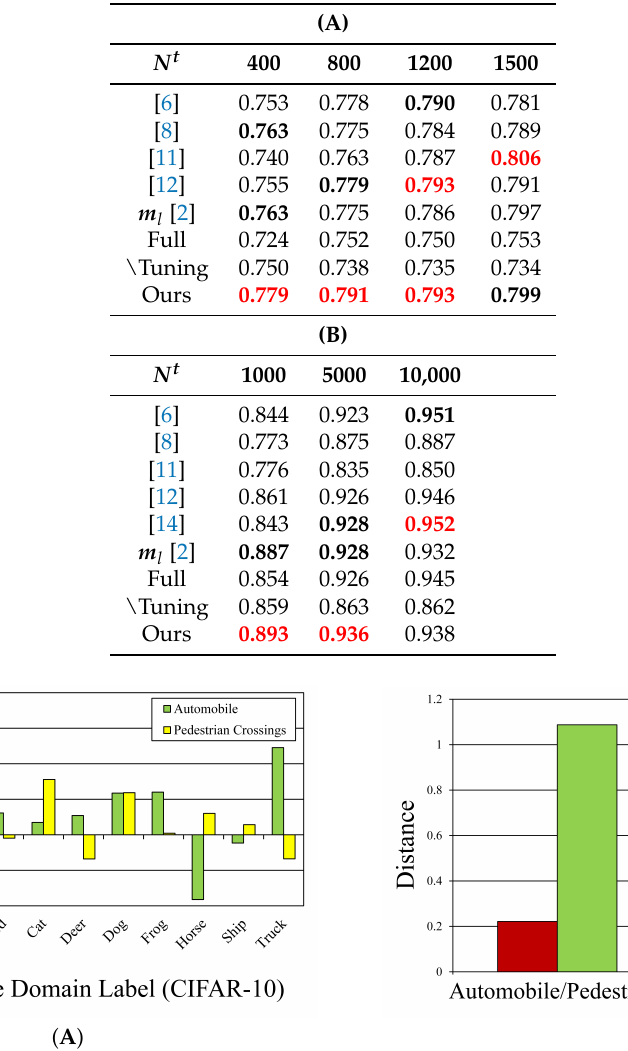
Table 1. Classification performances of ( A ) automobile and pedestrian crossings and ( B ) MNIST. The red bold is the best performance of each evaluation. The black bold is the second best performance.